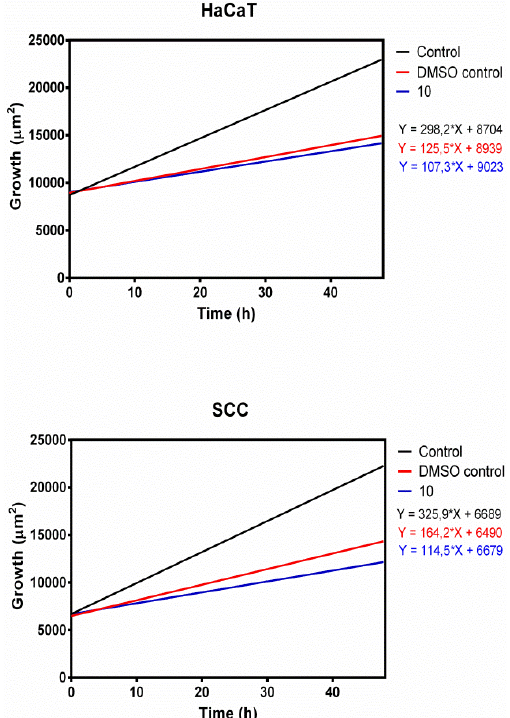
Figure 6. Effect of DMSO and compound 10 on confluency of HaCaT and SCC